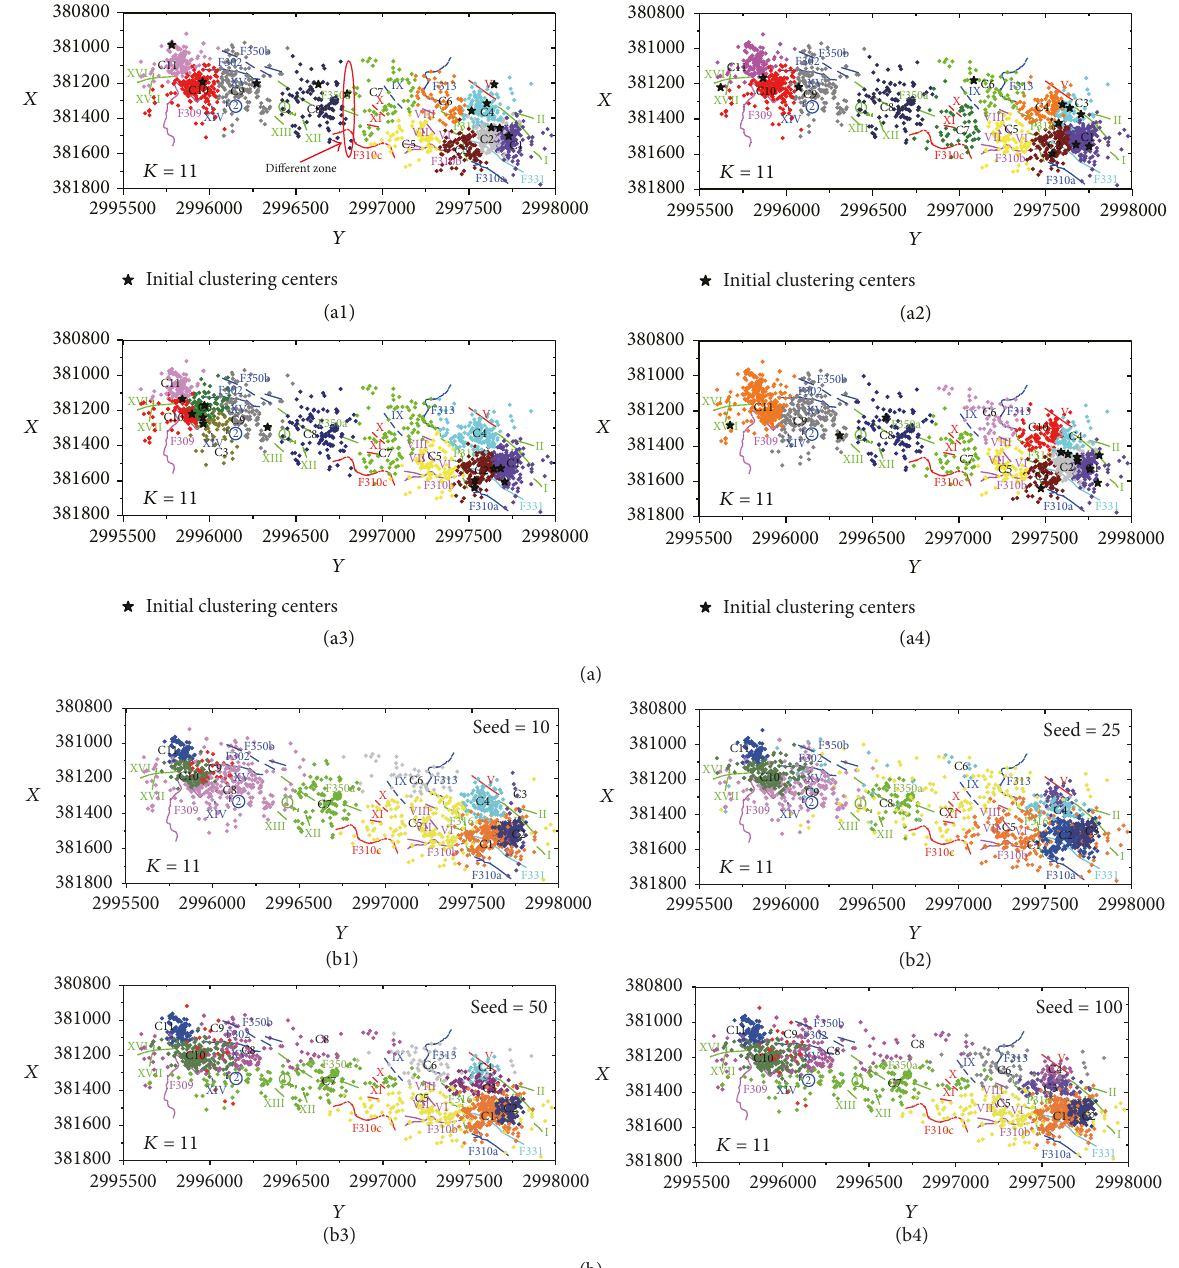
Figure 7: Cluster results ( 𝐾 = 11 ) of 𝐾 -Means and GMM with different cluster parameters. (a) 𝐾 -Means cluster with different initial clustering centers; (b) GMM cluster with different cluster seeds. (b1) Seed = 10; (b2) Seed = 25; (b3) Seed = 50; (b4) Seed = 100. The solid lines represent determined faults, while the dashed lines represent inferred faults by mine geologists. The symbols A and B represent two caves, and the triangles represent the location of